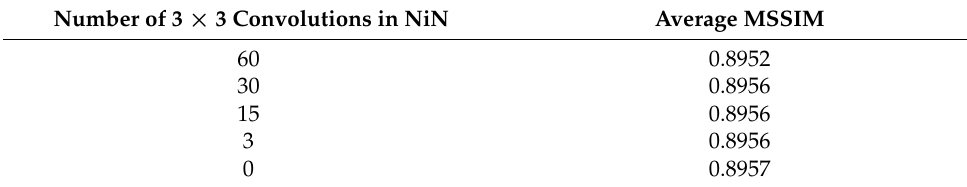
Table 3. Average MMSIM for varying number of convolutions with a 3 × 3 filter in the NiN stage.